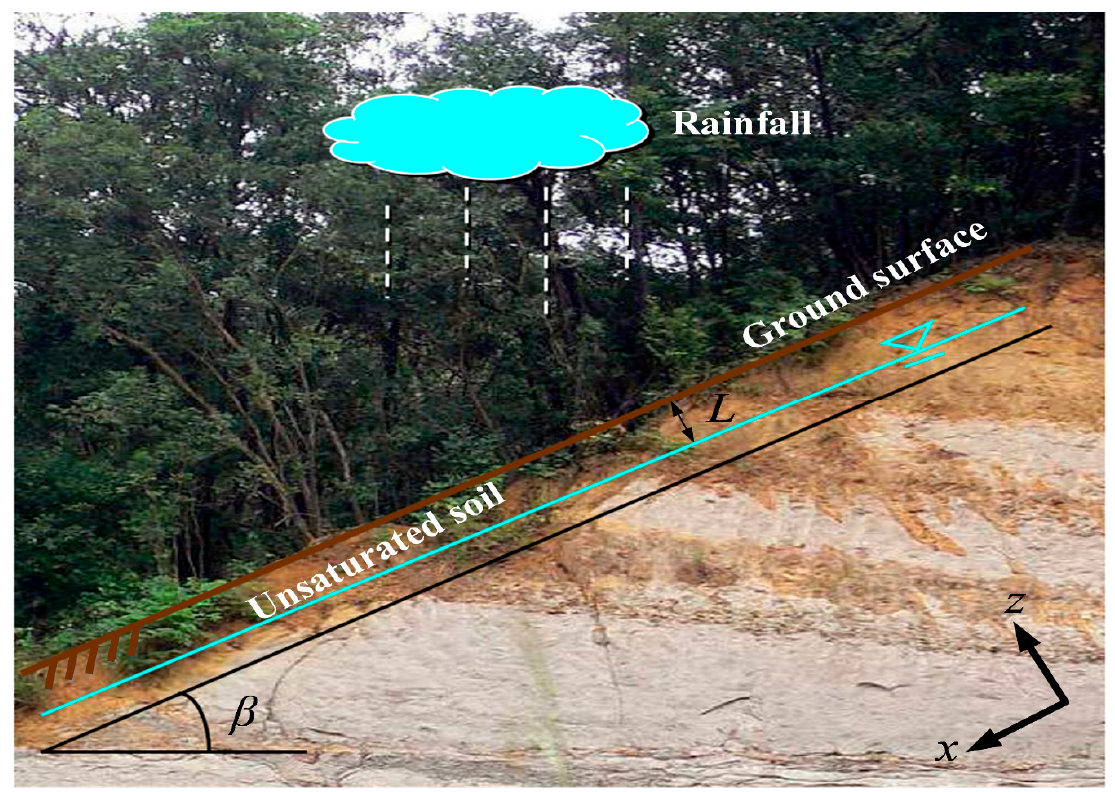
Figure 12. Illustration of unsaturated inclined